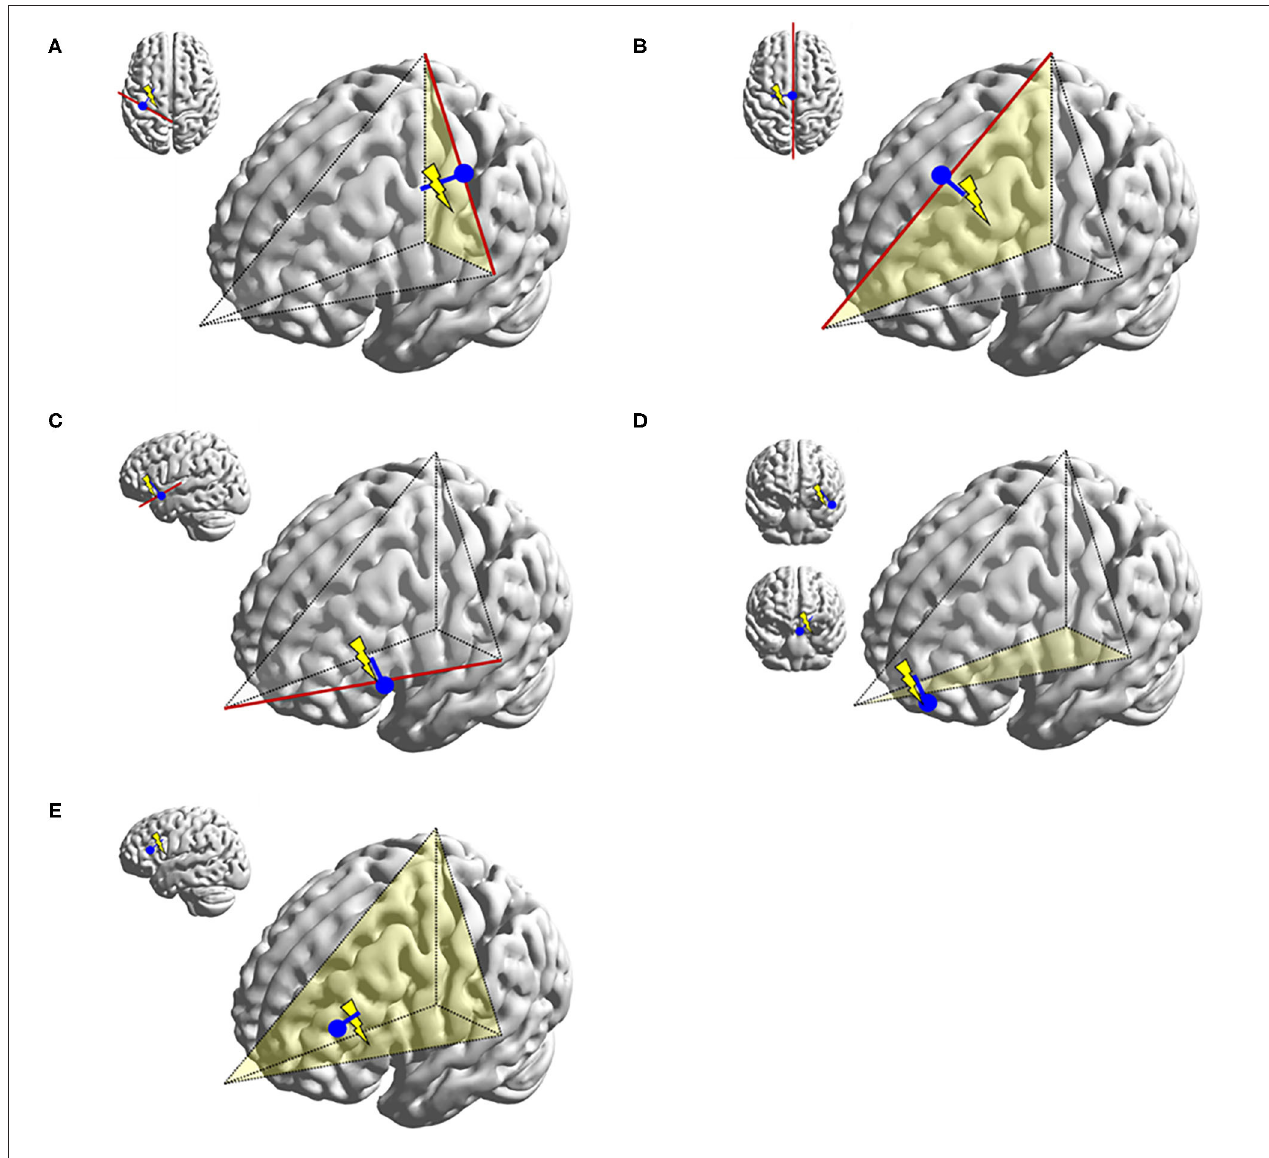
FIGURE 10 | Illustrations representing typical dipoles (blue) in correlation to frontal spike sources (electric symbol). (A) Peri-Rolandic frontal sources exhibit dipoles with anterior vector orientation. (B) Left medial frontal source exhibit lateral vector orientation to the left. (C) Fronto-opercular source exhibit upward vector orientation. (D) Orbitofrontal sources exhibit superior vector orientation similar to fronto-opercular source, but somewhat more oblique. Dipole tails of lateral orbitofrontal sources point more medially and those of medial orbitofrontal sources more laterally. (E) Lateral frontal dipole is shown here with dipole direction oriented toward the source, but its localization would also be dependent on the dipole cluster topology. This diagram can also be applied to parietal and occipital dipoles.